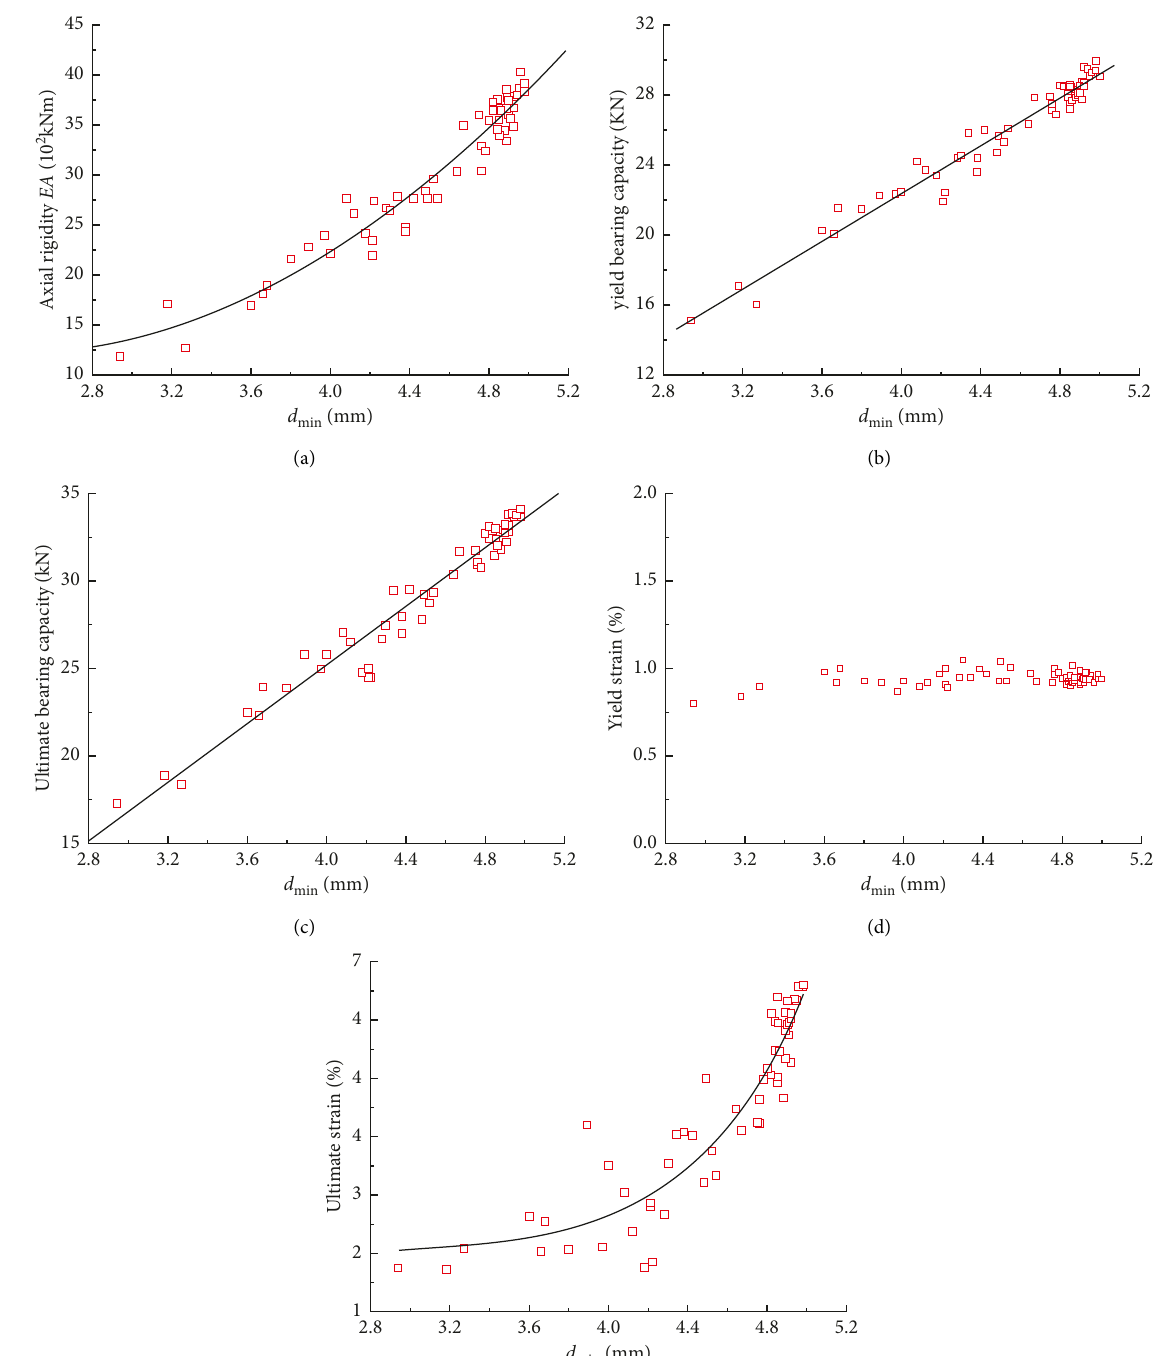
Figure 4: Change law of different mechanical parameters. (a) Axial stiffness degradation. (b) Yield bearing capacity degradation. (c) Deterioration of ultimate bearing capacity. (d) Yield strain degradation. (e) Ultimate strain